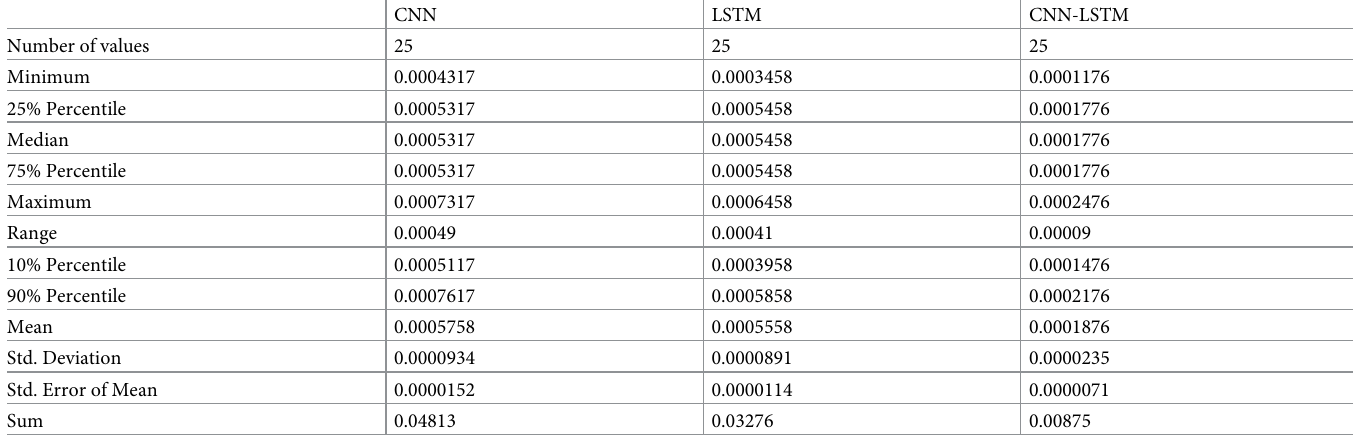
Table 3. The descriptive statistics of the CNN, LSTM, and CNN-LSTM algorithms.